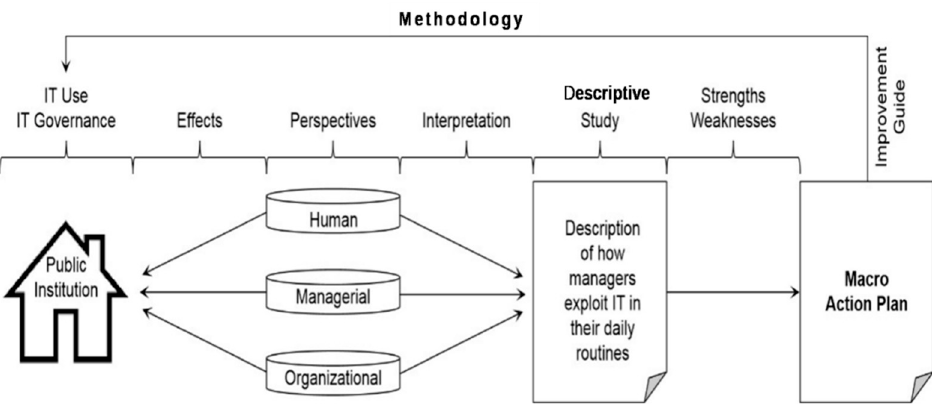
Figure 1. Design of the research.